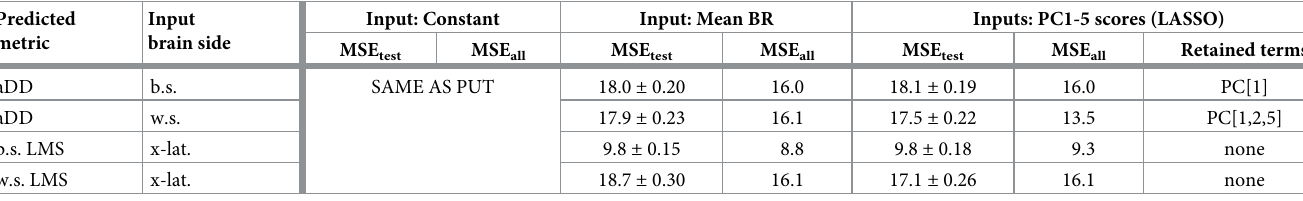
Table 4. Prediction MSEs of DTBZ-based models